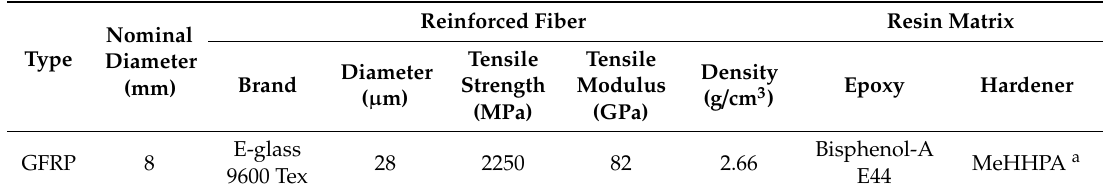
Table 1. Production parameters of fiber-reinforced polymer (FRP) bars.